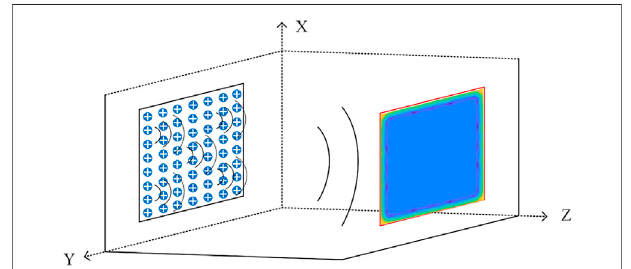
FIGURE 1 | PWG system model.